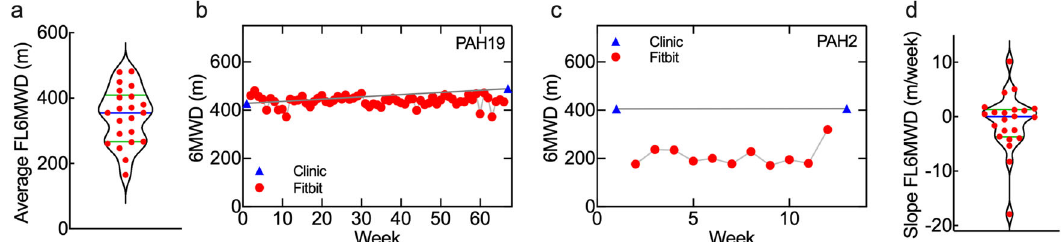
Fig. 6 Clinic 6MWD and FL6MWD. a Violin plot showing distribution of average values of FL6MWD for all subjects. Mean = 344 m. Blue bar – mean; green bars – upper and lower quartiles. b Example of a subject with good agreement between FL6MWD and interpolated clinic values (group 1, “ performer ” ). (Triangles) clinic values, (circles) FL6MWD. The grey line shows the linear interpolation of the clinic values. c Example of a subject where the FL6MWD was lower than the interpolated clinic values (group 2, “ underperformer ” ). (Triangles) clinic values, (circles) FL6MWD. The grey line shows the linear interpolation of the clinic values. d Violin plot of the slope of the FL6MWD (m/week) over time for all subjects. Blue bar – mean; green bars – upper and lower quartiles.